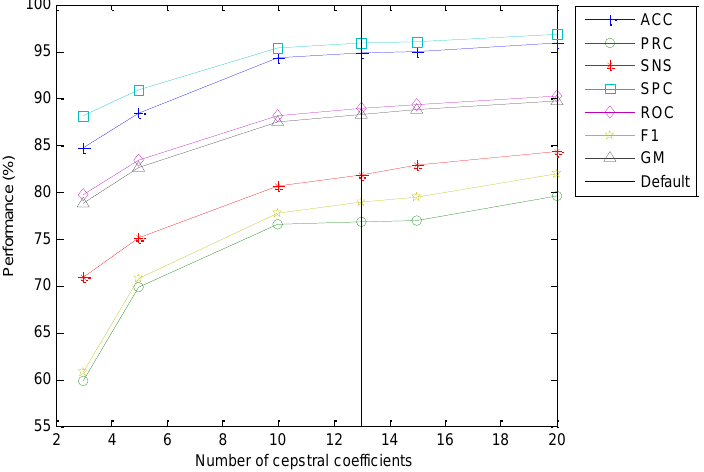
Figure 27. Classification performance metrics of the best classifier vs. the number of cepstral coefficients.